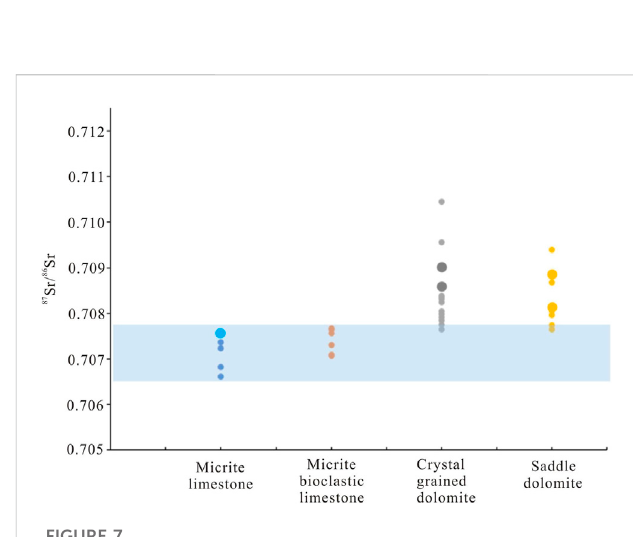
FIGURE 7 87 Sr/ 86 Sr isotopic characteristics of different lithologies of Permian Qixia Formation in Central Sichuan Basin (partial data from Jiang et al., 2018). The blue area represents the 87 Sr/ 86 Sr range (.70662 – .70774) of Permian seawater; the enlarged symbol data comes from Jiang et al.,